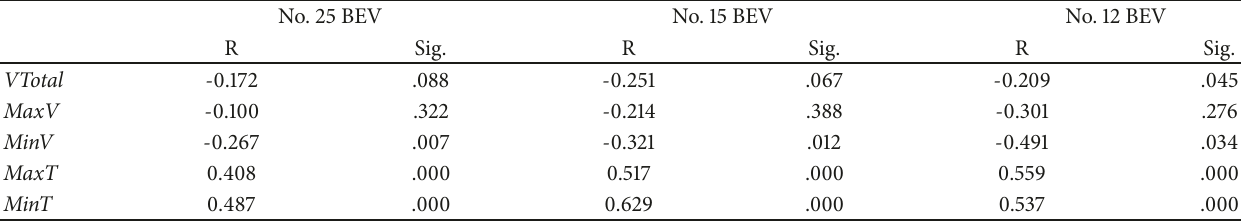
Table 4: Partial correlation test results under SOC is